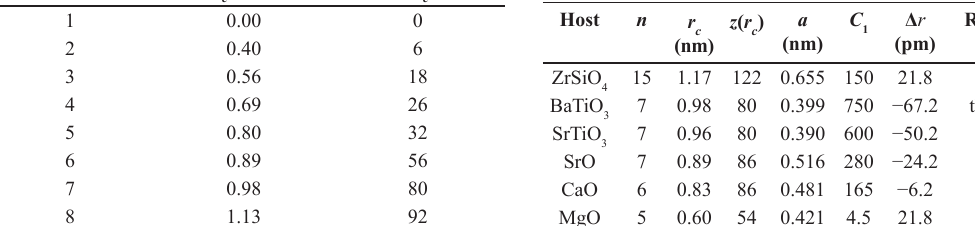
Table 3. Values of r